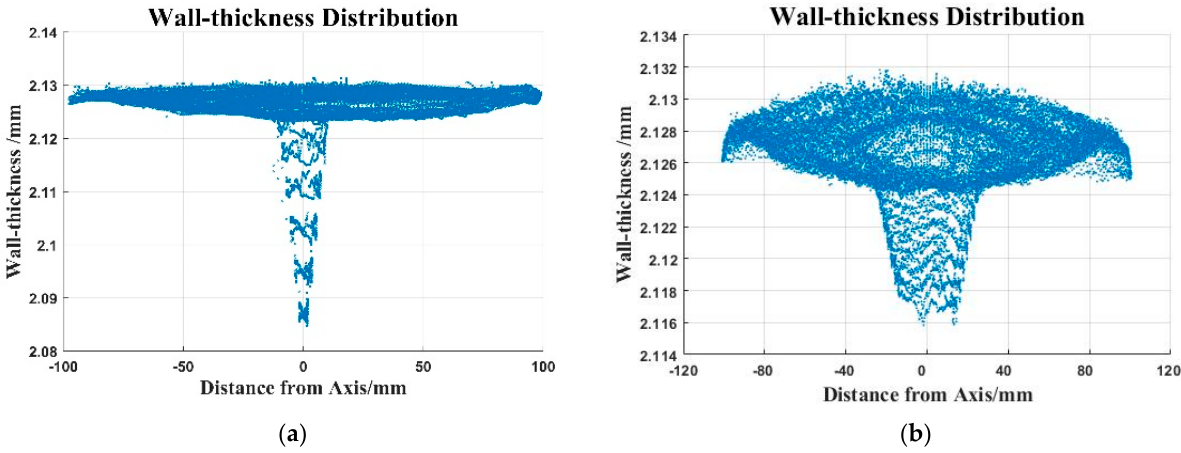
Figure 13. The wall ‐ thickness distribution (Cartesian coordinates): ( a ) the wall ‐ thickness distribution (the meridian trajec ‐ Figure 13. The wall-thickness distribution (Cartesian coordinates): ( a ) the wall-thickness distribution (the meridian tory); ( b ) the wall ‐ thickness distribution (the concentric trajectory). trajectory); ( b ) the wall-thickness distribution (the concentric